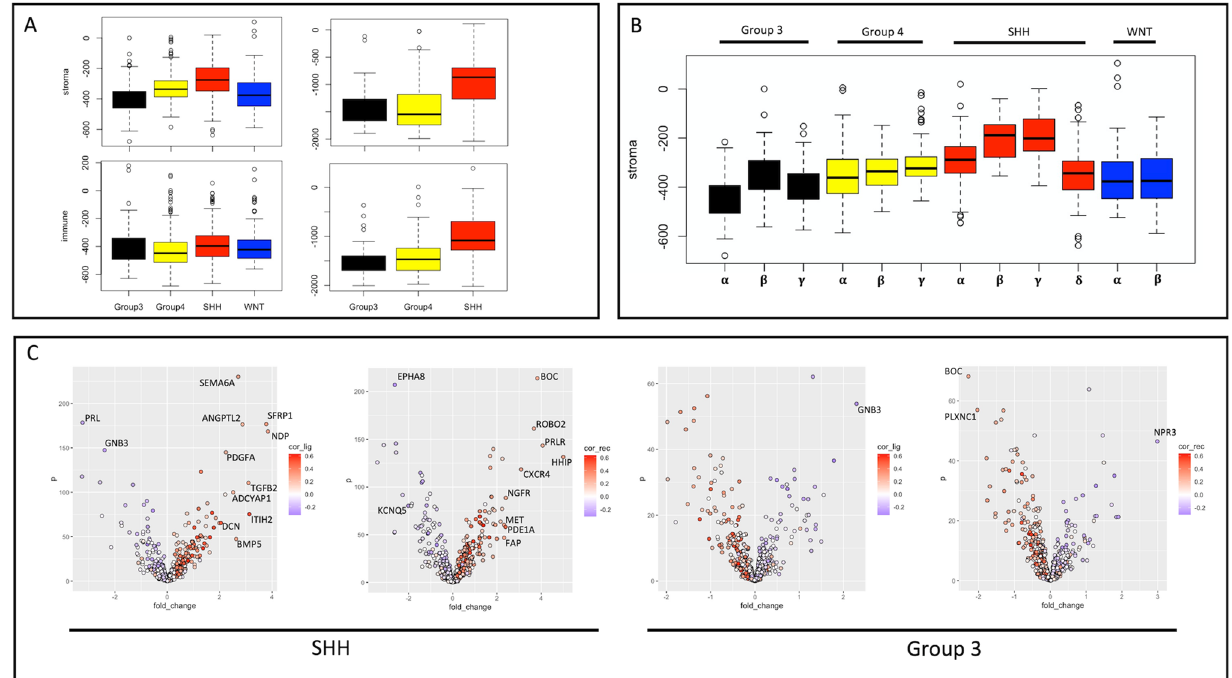
Figure 1. Stromal microenvironment is enriched in SHH-subtype medulloblastoma and suppressed in group 3. ( A ) ESTIMATE calculation of stroma (upper) and immune (lower) scores by molecular subgroup. Discovery cohort is plotted on the left and validation cohort is on the right. ( B ) Boxplot of stromal score by molecular subtype (ANOVA p < 0.05). ( C ) Volcano plots of differentially expressed ligand (left) and receptor (right) genes for SHH (stroma-upregulated) and group 3 (stroma-downregulated). For each subgroup, comparison is made to the pooled amalgamation of the remaining 3 subgroups. Each receptor/ligand gene is coloured based on its correlation with stromal signature score, with red indicating positive correlation and blue indicating negative correlation. Those with absolute fold-change > 2 and absolute Pearson correlation > 0.2 (labeled) are selected as potential drivers of subgroup-specific stromal differences (drivers of stroma signature in SHH-subgroup and repressors of stromal signature in group